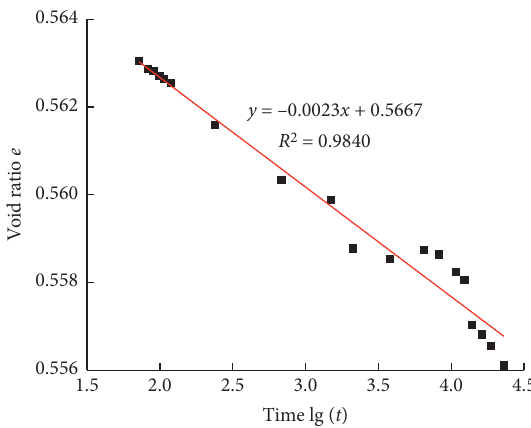
Figure 7: e − lg ( t ) curve at E